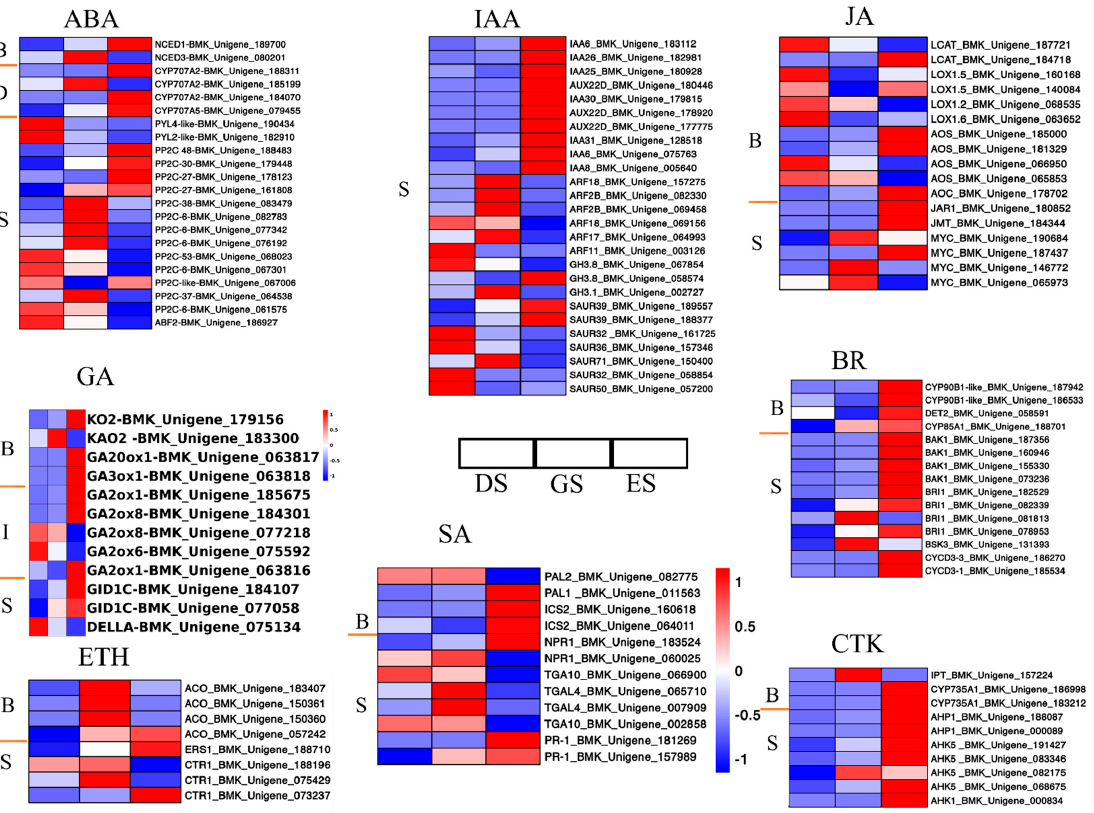
Figure 6. Expression profiles of the DEGs involved in plant hormone biosynthesis, degradation, and signaling pathways in P. cyrtonema seeds during germination process. Note: B means Biosynthesis, D means degradation, I means inactivation, and S means signaling.